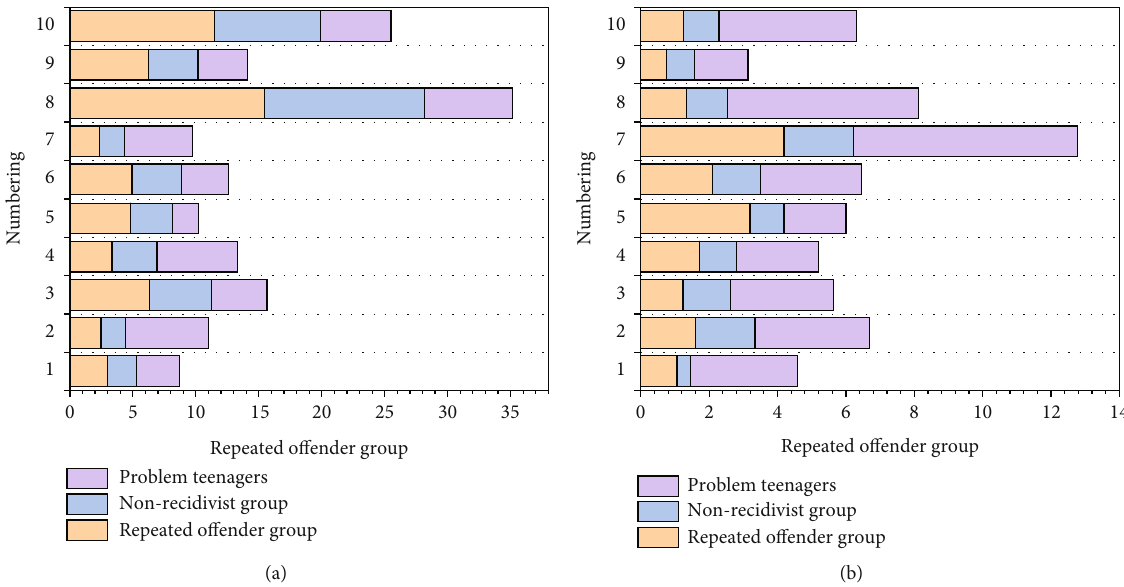
Figure 3: OR values of di ff erent groups of adolescents compared with normal youths in SCH and FAM scales ((a) OR values in SCH scale and (b) OR values in FAM scale).